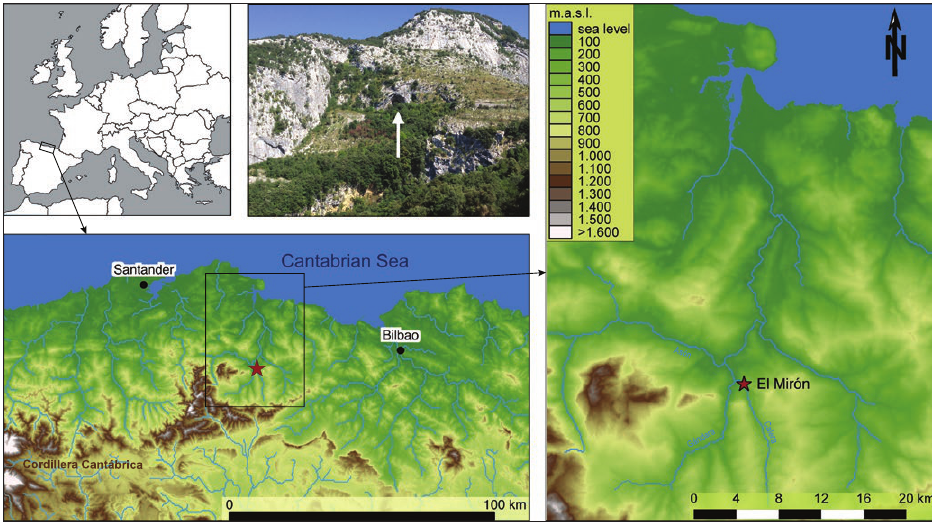
Figure 1: The site of El Mirón is located at the northwest slope of Monte Pando (Ramales de la Victoria) in Cantabria, Northern Spain; at the confluence of the rivers Caldera, Gandára and Asón surrounded by 1000m high mountains in the first main chain of the Cantabrian